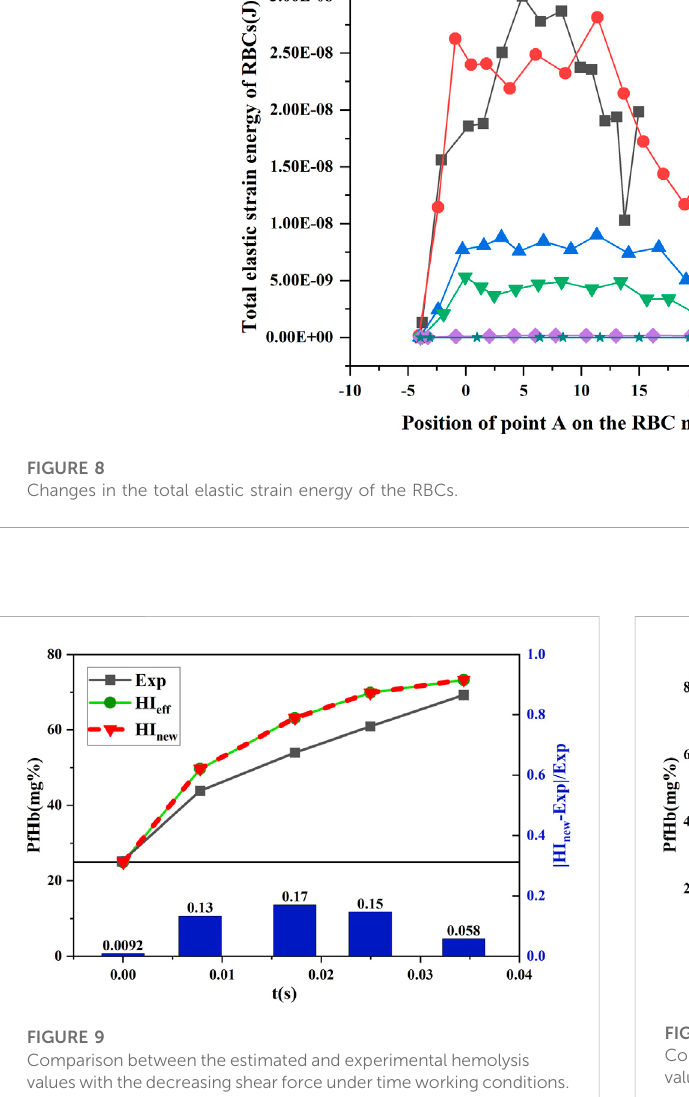
Figure 9 and Figure 10 show that HI eff and HI new coincide.